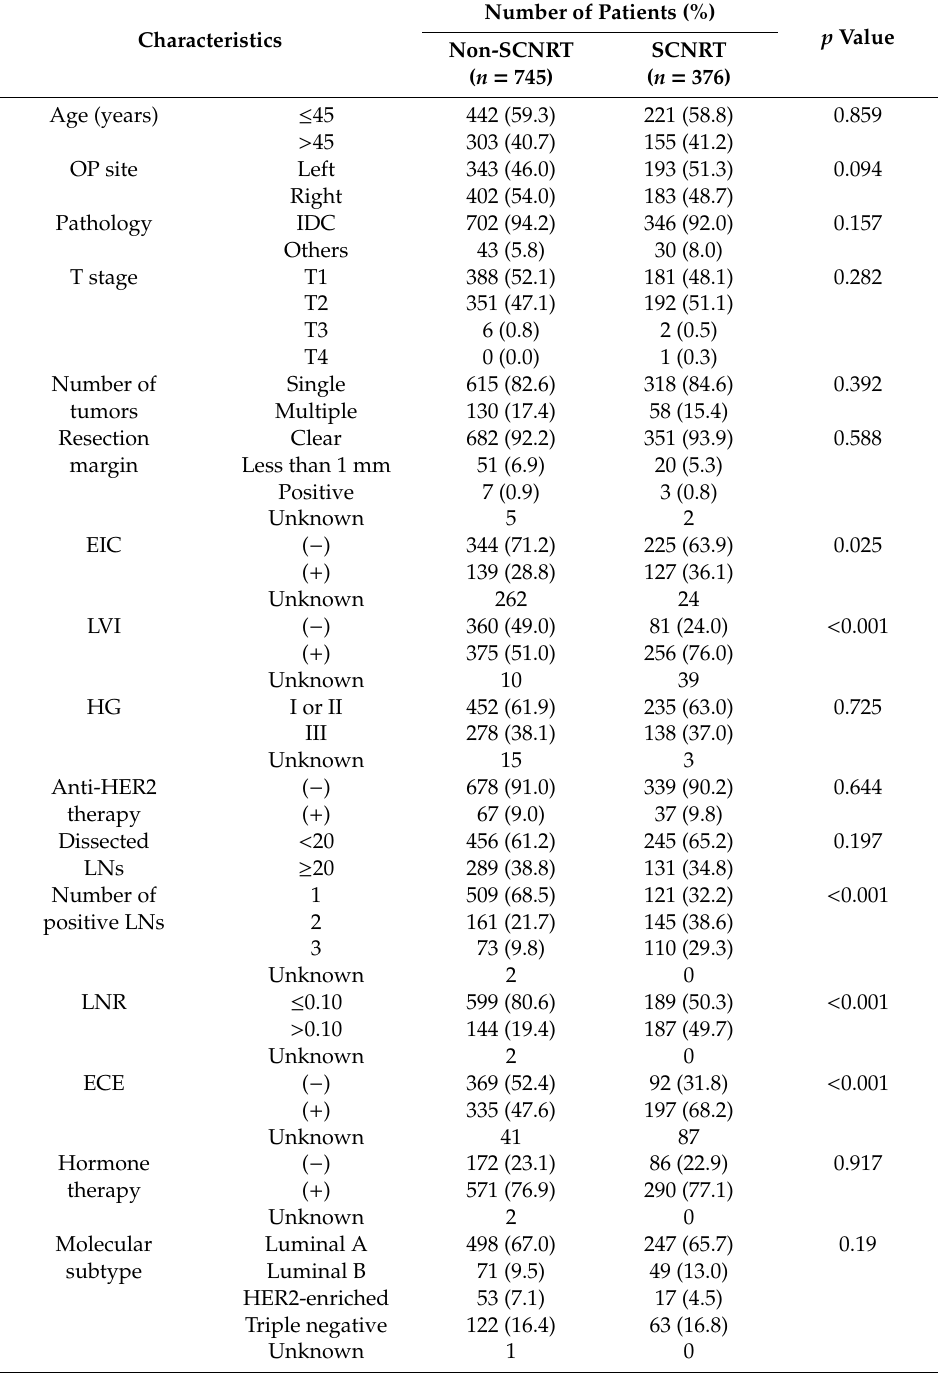
Table 1. Patient